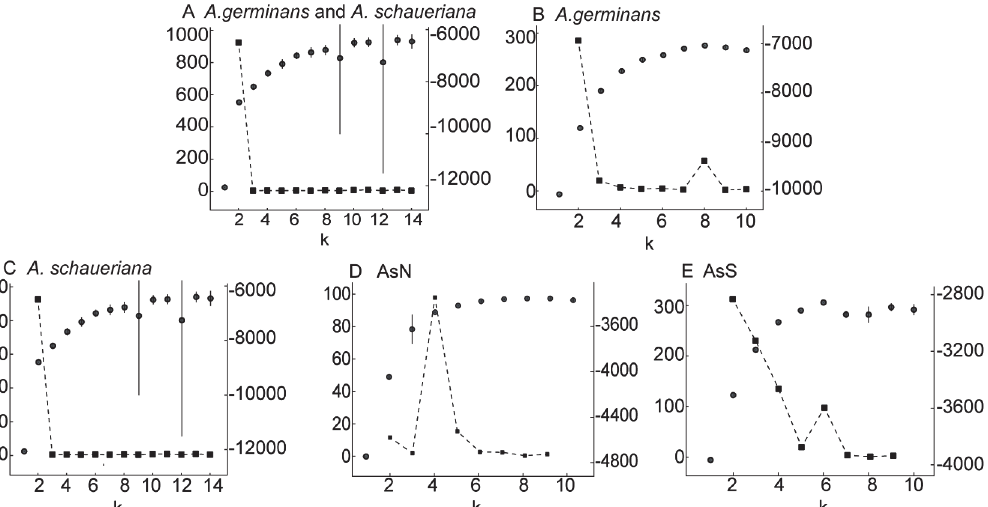
Fig 6. Bayesian inference of cluster number (k). The mean values of log posterior probability of data (lnL — isolated gray circles, left-axis [38]) and the Δ K ad hoc statistic (interconnected squares, right axis [40]) considering A) samples of both A . germinans and A . schaueriana , B) samples of A . germinans , C) individuals of A . schaueriana from all locales sampled, D) individuals of A . schaueriana from the northern cluster (AsN), and E) samples of A . schaueriana from the southern cluster (AsS).